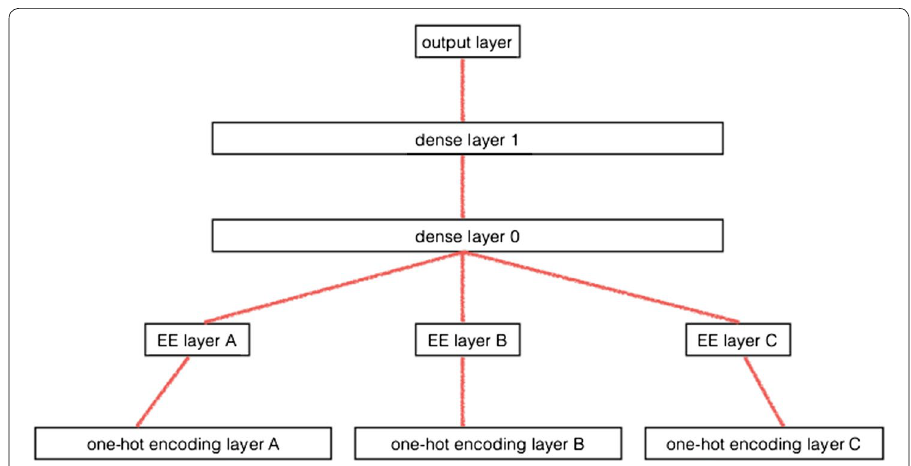
Fig. 2 Image copied from [3]. The authors perform experiments with and without embedding layers. The schematic here shows the Author’s approach when they use embedding layers. Categorical variables are embedded separately, then the output of the embedded layers are concatenated and fed forward to dense